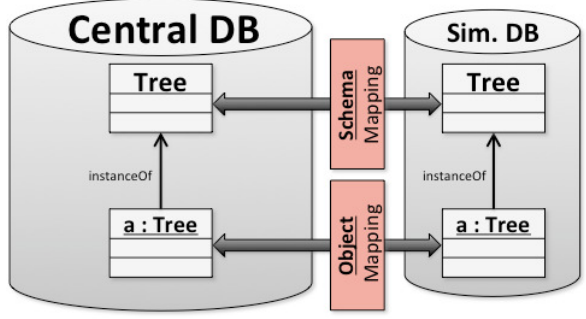
Figure 7. Schema and data synchronization between a central (geo) database and a simulation